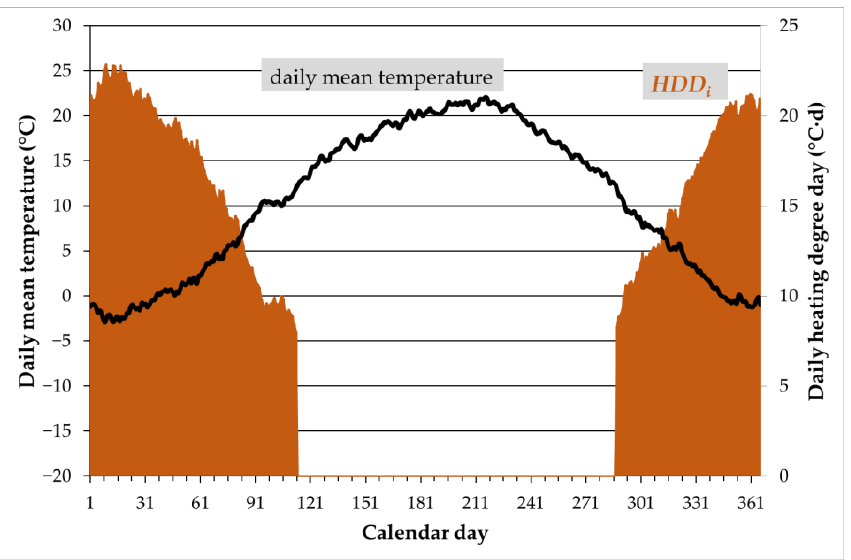
Figure 3. Daily mean temperature and daily heating degree day values throughout a year in Debrecen based on the mean values in the reference period of 1961 – 2010.